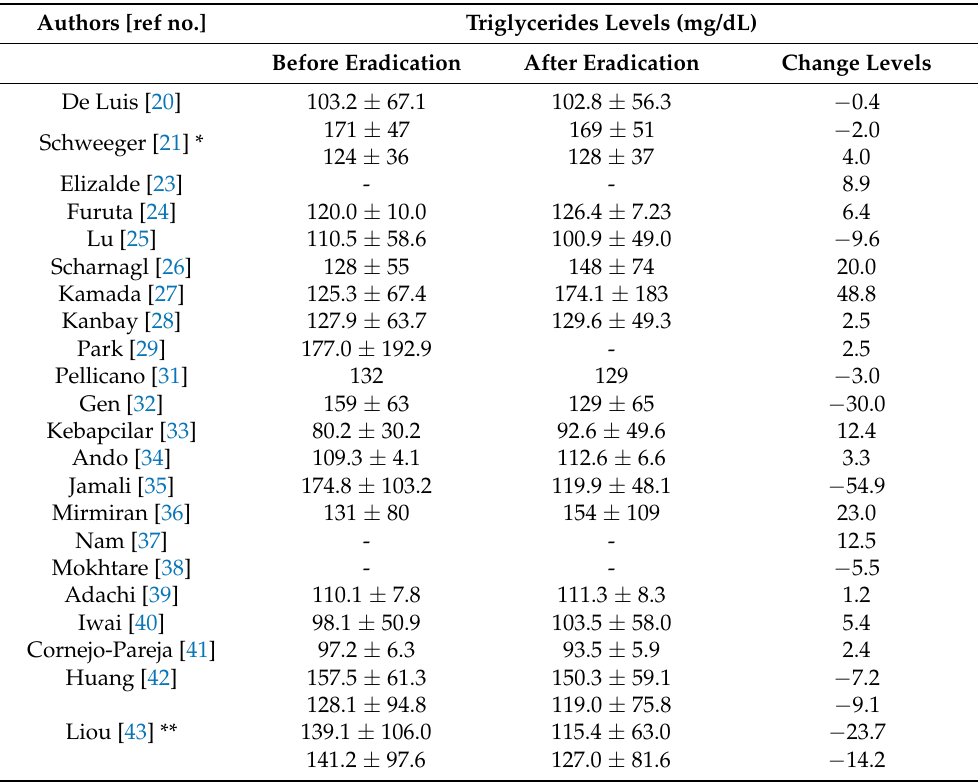
Table A2. Summary of levels of triglycerides before and after eradication. Authors [ref no.]